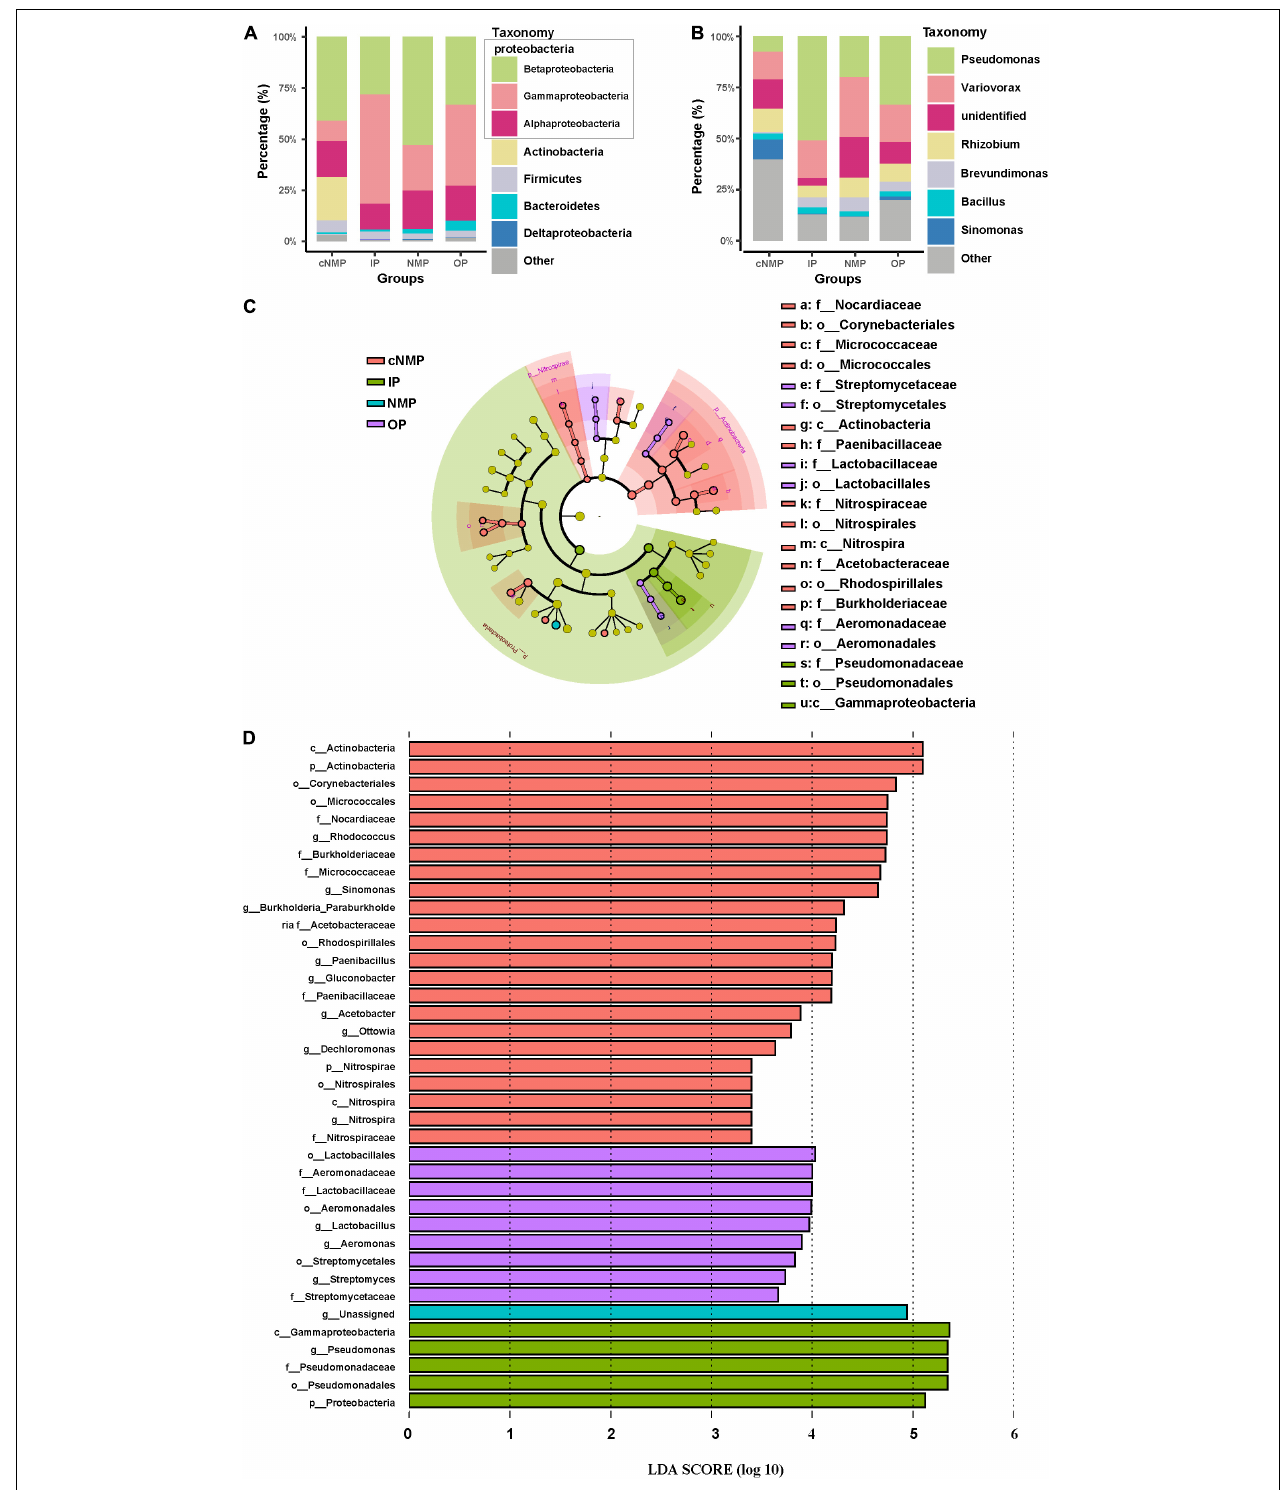
FIGURE 3 | Relative abundance at (A) the phylum level (Proteobacteria at the class level) and (B) the genus level in DPR inoculated with different phosphorus sources. Taxonomic differences of DPR microbiota between four phosphorus sources from the LefSe method. (C) Taxonomic cladogram. The taxa with enrichment levels in different phosphorus sources are displayed in various colors. (D) The LDA scores observed for individual taxa that passed the LefSe significance threshold. The three species at the class level that belonged to Proteobacteria are shown in gray box in panel (A) . DPR, denitrifying phosphorus removal; LefSe, linear discriminant analysis effect size; LDA, linear discriminant